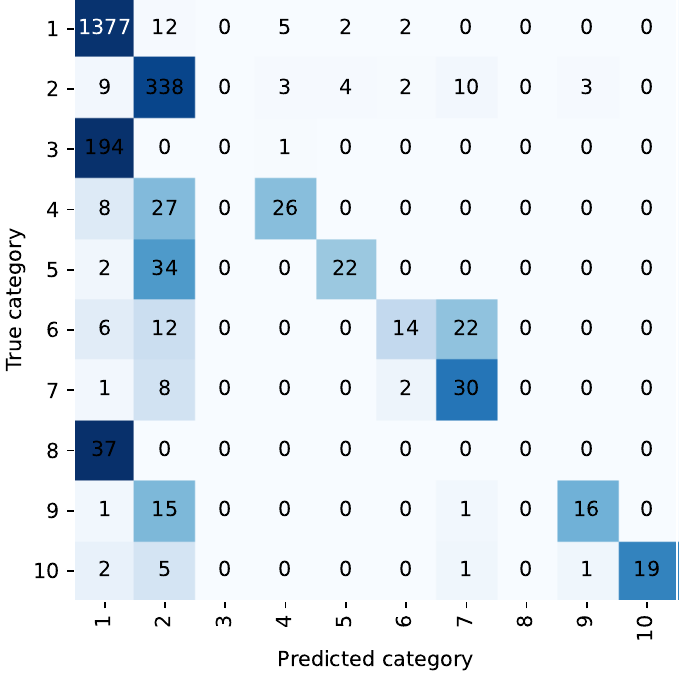
Figure 3. Confusion matrix of integration-LP method.